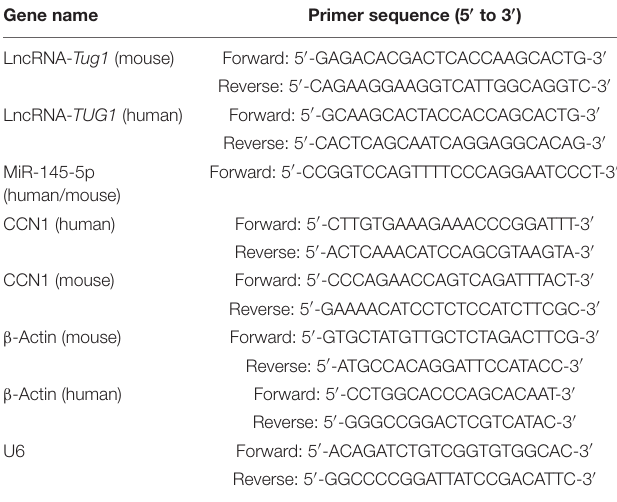
TABLE 1 | Primer sequences used for